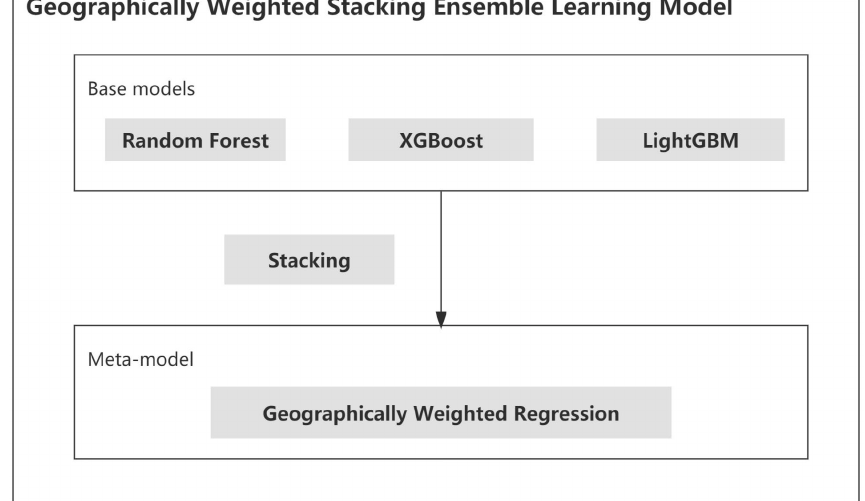
Figure 4. Structure of GWSE.